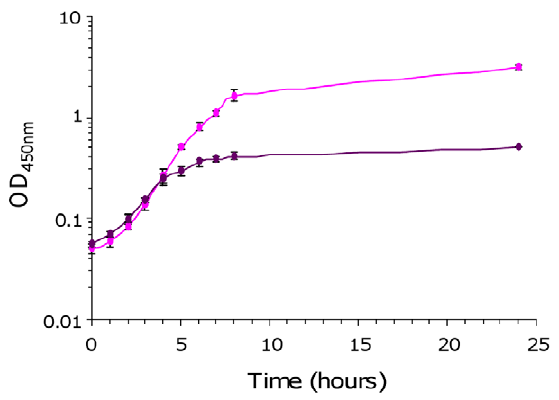
Figure 1. Growth of E.coli strain BEN2908 in the presence of scFOS at 37 6 C and 41.5 6 C. Growth curves (OD 450 nm ) of strain BEN2908 grown with shaking at 37 u C (pink circle) or 41.5 u C (purple circle) in M9 minimal medium supplemented with 0.2% scFOS. The average values and standard deviations result from three independent